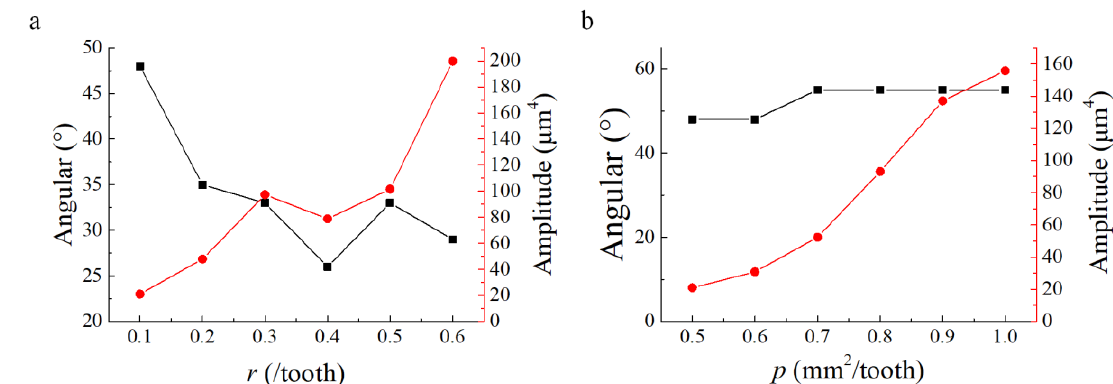
Figure 6. Effect of p and r on the peak amplitudes of the angular spectrum and the corresponding angular. ( a ) Effect of r ; ( b ) Effect of p.